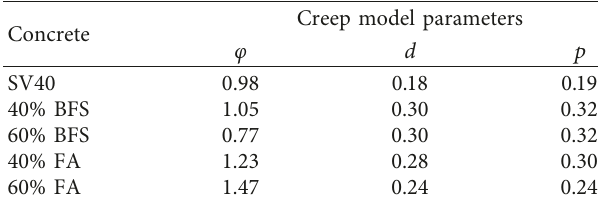
Table 4: Creep parameters in DPL for the compressive creep tests.